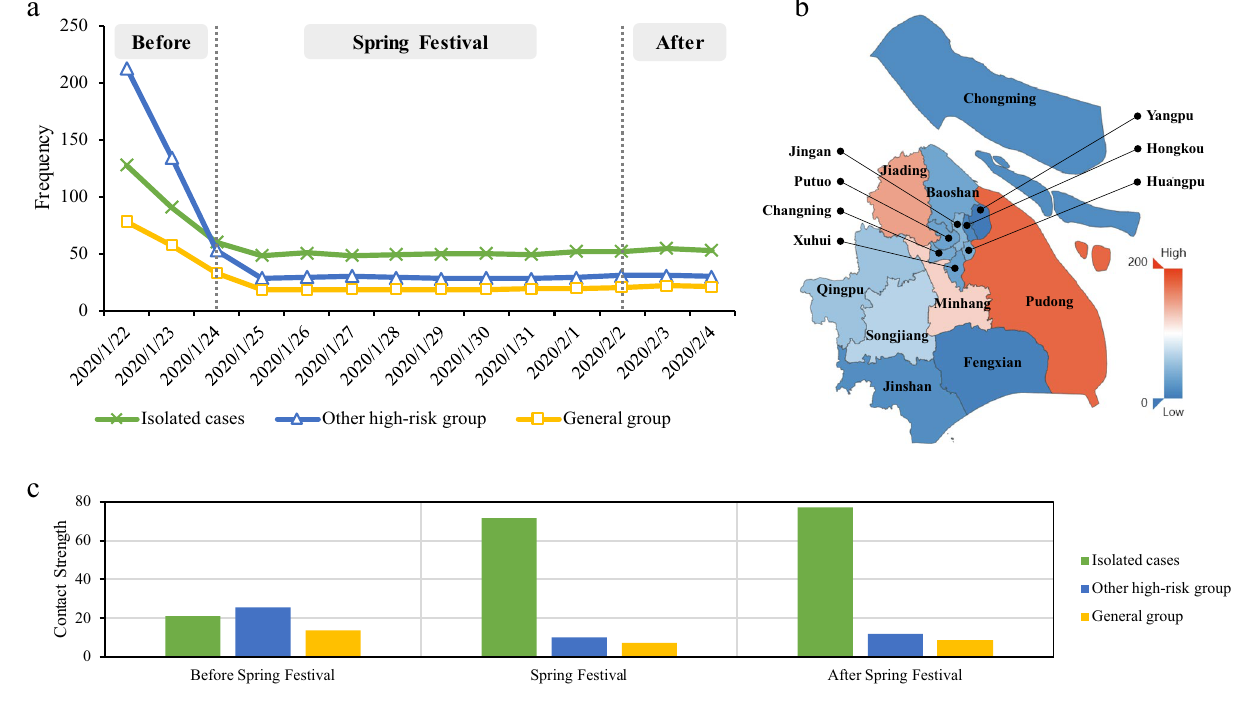
Figure 3. Crowd contact features of COVID-19 in the early stage. ( a ) The daily effective contact frequency per capita. The Spring Festival holiday in 2020 was originally from January 24 to January 30, then extended to February 2 due to COVID-19. On January 23, Wuhan announced the lockdown of the city and other local governments called on people to reduce unnecessary outdoor activities and maintain social distance. ( b ) Map of high-risk group’s average effective contact frequency. ( c ) Contact strength before and after the Spring Festival. We divided the fourteen days into three slots: before the Spring Festival (January 22–January 23), the Spring Festival (January 24–February 2) and after the Spring Festival (February 3–February